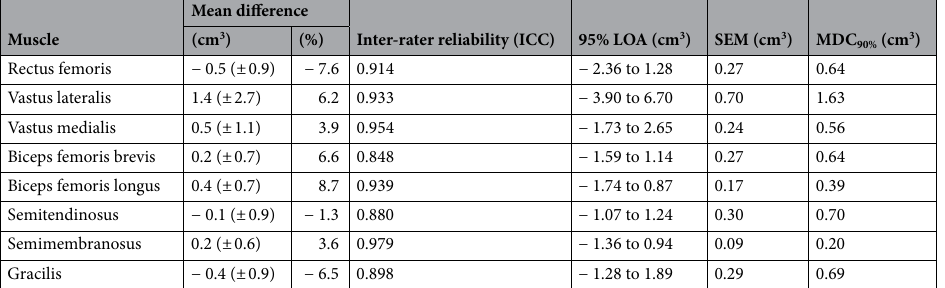
Table 3. Inter-rater reliability measurements for the thigh muscles of infants aged 6 months and under. Percentage mean difference was calculated based on mean muscle volumes. LoA limits of agreement, SEM standard error of measurement, MDC minimum detectable change. For mean difference, a −ve symbol indicates that rater 2, on average, reported a larger muscle volume than rater